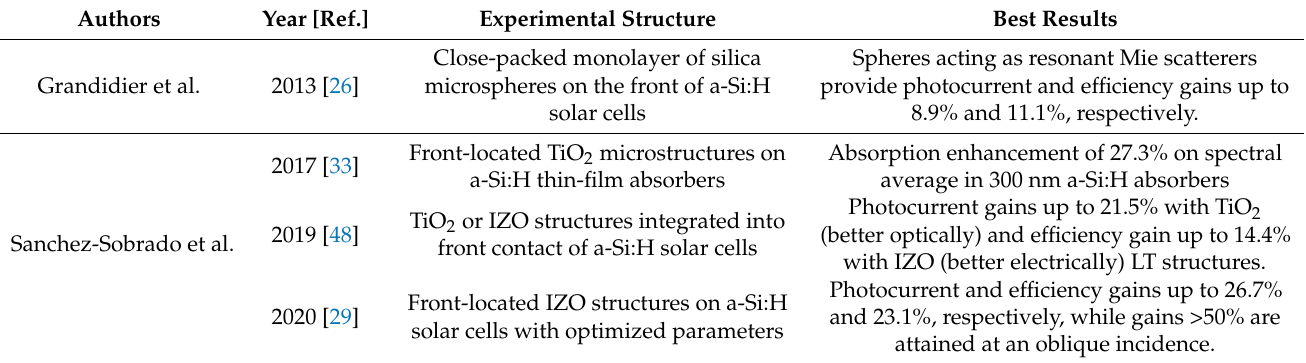
Table 2. Overview of experimental results on CL-fabricated microstructures for thin-film